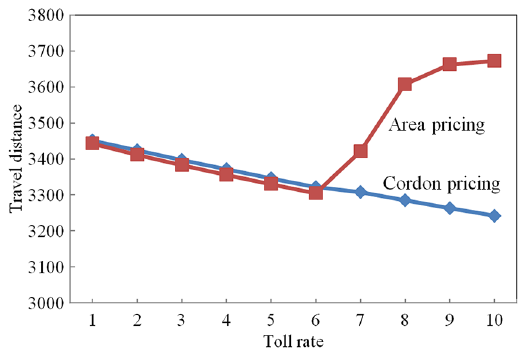
Fig. 4. Analysis of travel distance